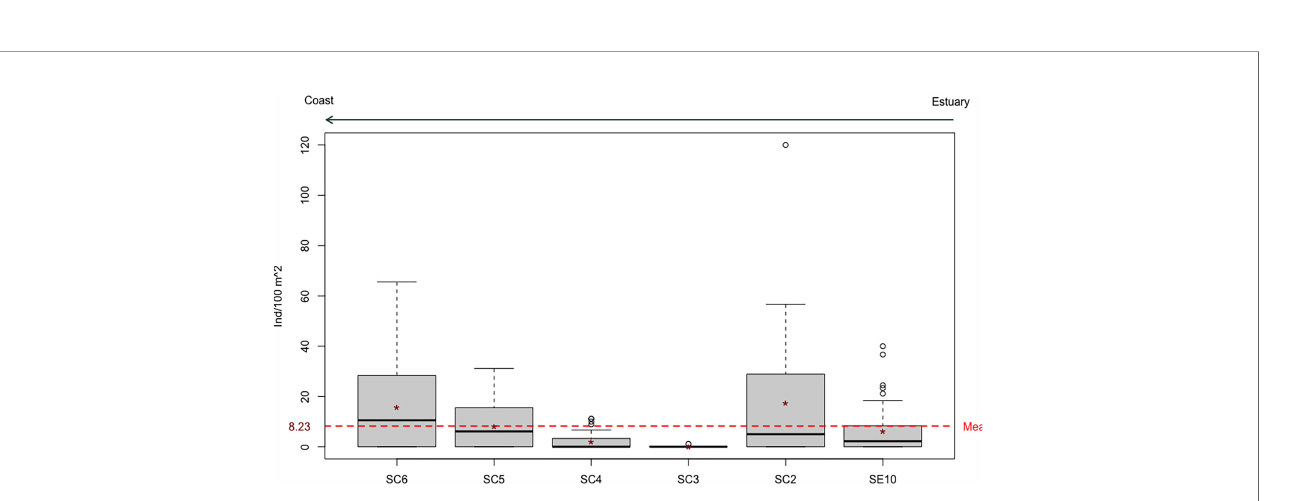
FIGURE 4 | Density of Holothuria mammata by sampling site, arranged according to distance to estuary (left to right). Red dotted line represents the overall mean value. * represents the mean of each sampling station.